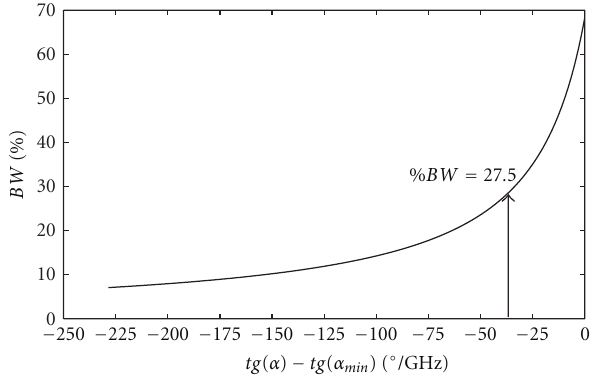
Figure 16: Percent bandwidth estimation ( D = 12 λ 0 , F/D = 1, Δ x = Δ y = 0 . 48 λ ).